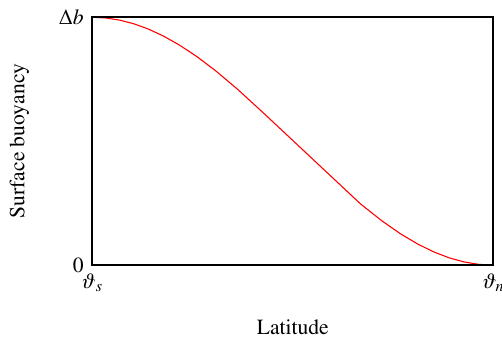
Fig. 2. Meridional surface buoyancy profile b 0 (ϑ)